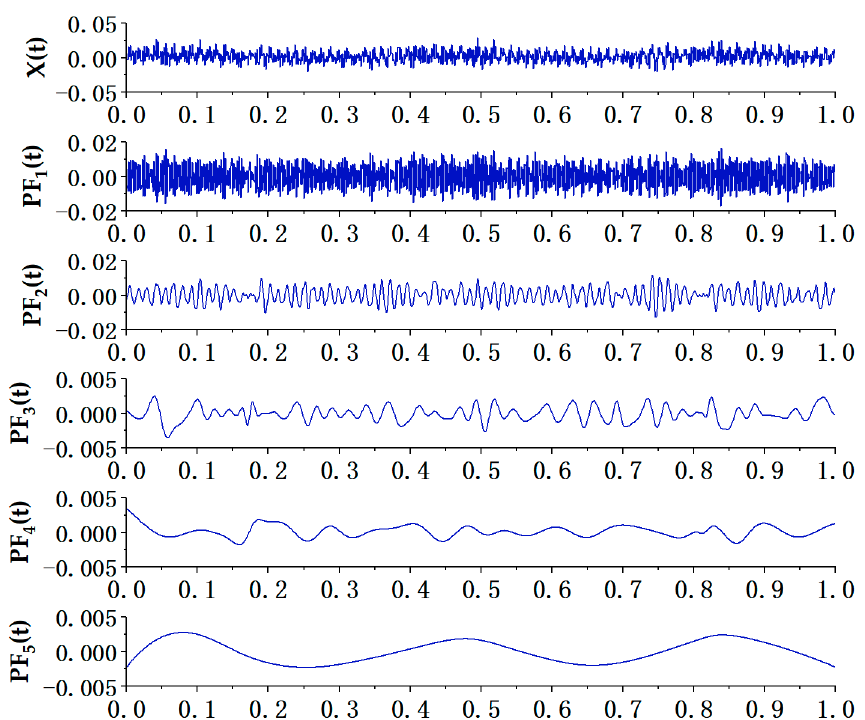
Figure 4. LMD motor vibration signal decomposition.